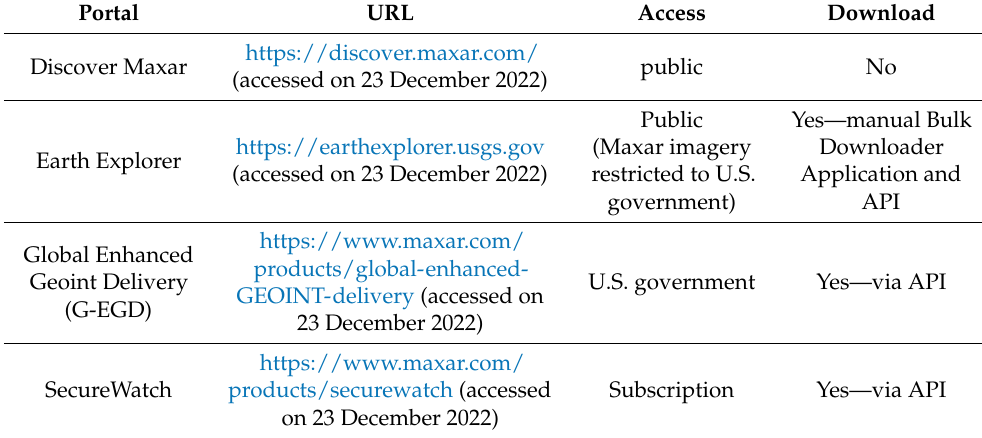
Table 4. Websites for browsing and downloading very high-resolution satellite